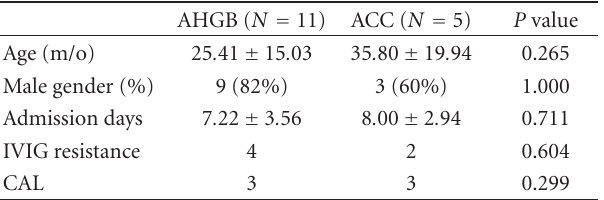
Table 5: Characteristic of AHGB versus ACC in Kawasaki disease